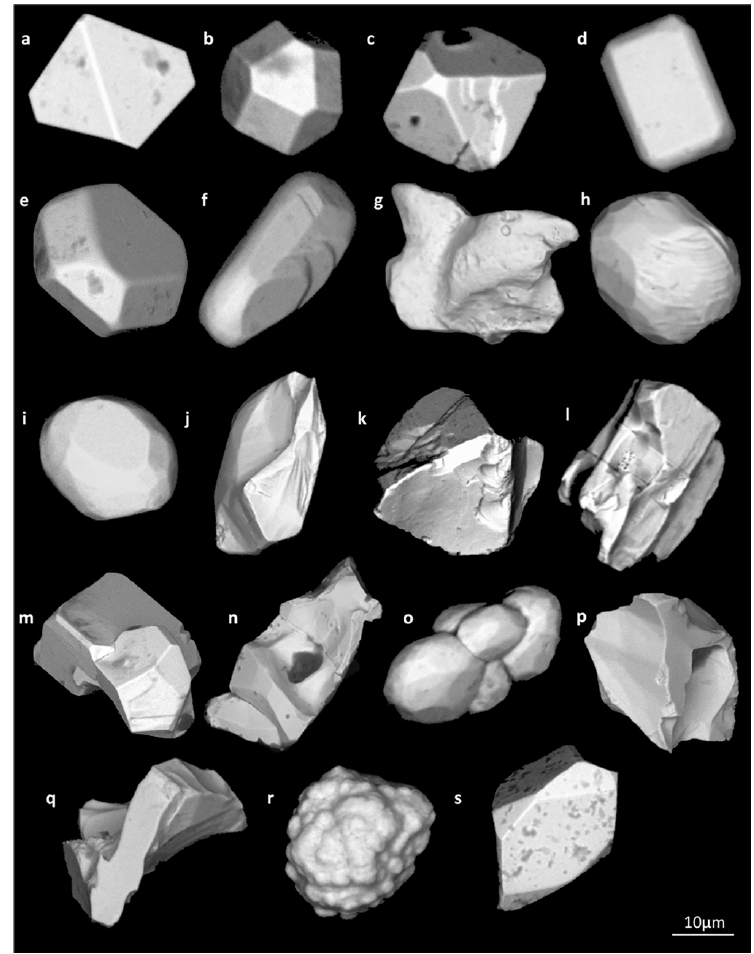
Figure 17. A selection of backscatter electron (BSE) images showing various shapes and morphologies of sperrylite grains recovered from till samples. ( a – d ) Pristine grains. ( e – f ) Semi-rounded grains. ( g – i ) Rounded grains. ( j – l ) Grains with breakage surfaces. ( m – o ) Monomineralic aggregates / twinned crystals. ( p , q ) Grains with intergranular textures. ( r ) Botryoidal form of a sperrylite. ( s ) Grain with corroded surface.